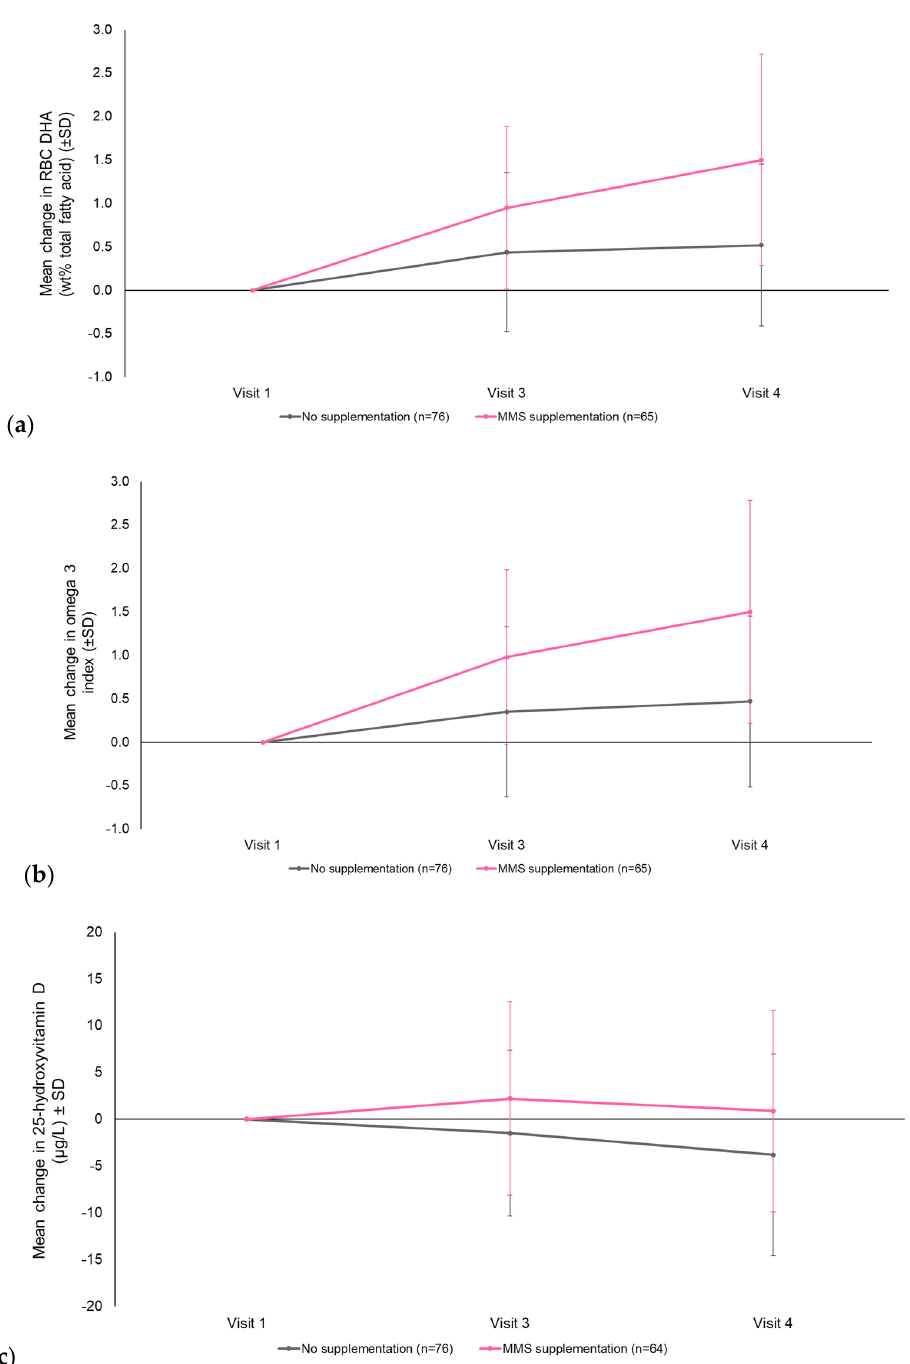
Figure 3. Mean change ( ± standard deviation) from Visit 1 to Visit 4 in maternal ( a ) RBC DHA ( wt % TFA) ( p < 0.0001 in favor of MMS), ( b ) omega 3 index ( p < 0.0001 in favor of MMS), and ( c ) calcidiol (25-hydroxyvitamin D) ( p = 0.0122 in favor of MMS) (per protocol population; LOCF approach). Visit 1: Screening (GA Week 11 / 14); Visit 3: GA Week 24 / 26; Visit 4: GA Week 34 / 36. DHA, docosahexaenoic acid; GA, gestational age; LOCF, last observation carried forward; MMS, multiple micronutrients and DHA supplementation; RBC, red blood cells; SD, standard deviation; TFA, total fatty acids; wt , weight.